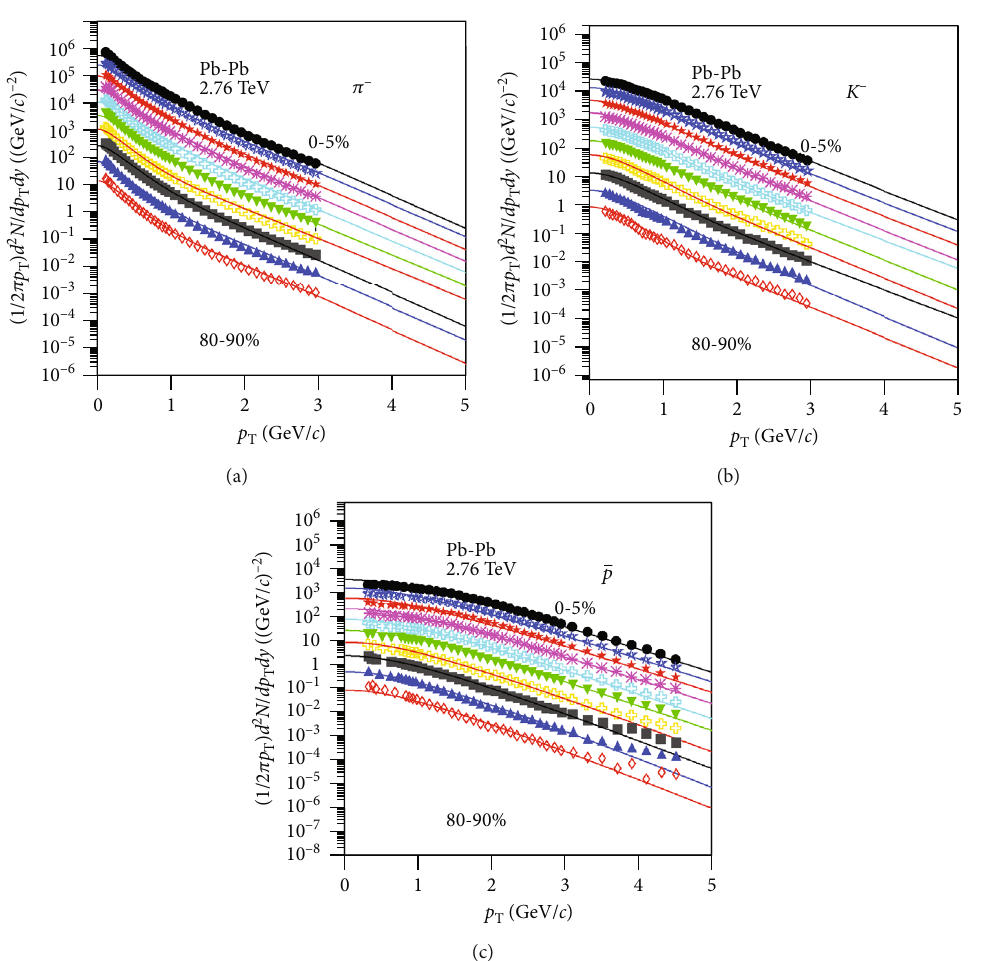
ffiffiffiffiffiffiffiffi p = 2 : 76 TeV . The symbols represent the s NN